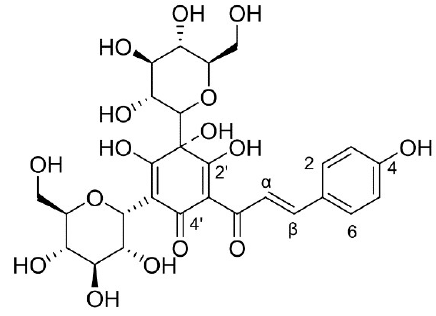
Figure 1. Chemical structure of HSYA.